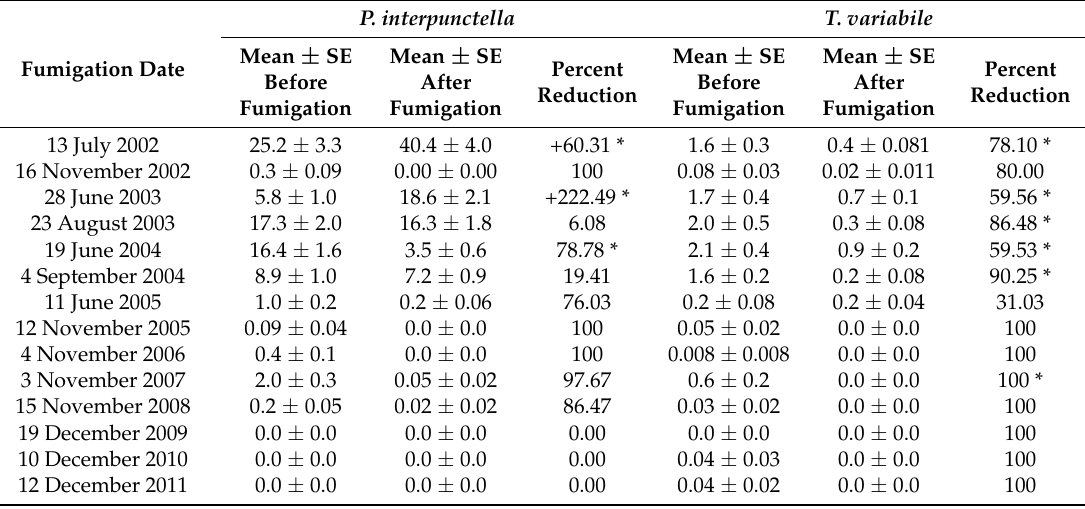
Table 4. Change in fumigation for all inside locations combined. Before and after fumigation includes 1 month of insect capture data, or two trapping periods. SE = standard error; * = significant at p <